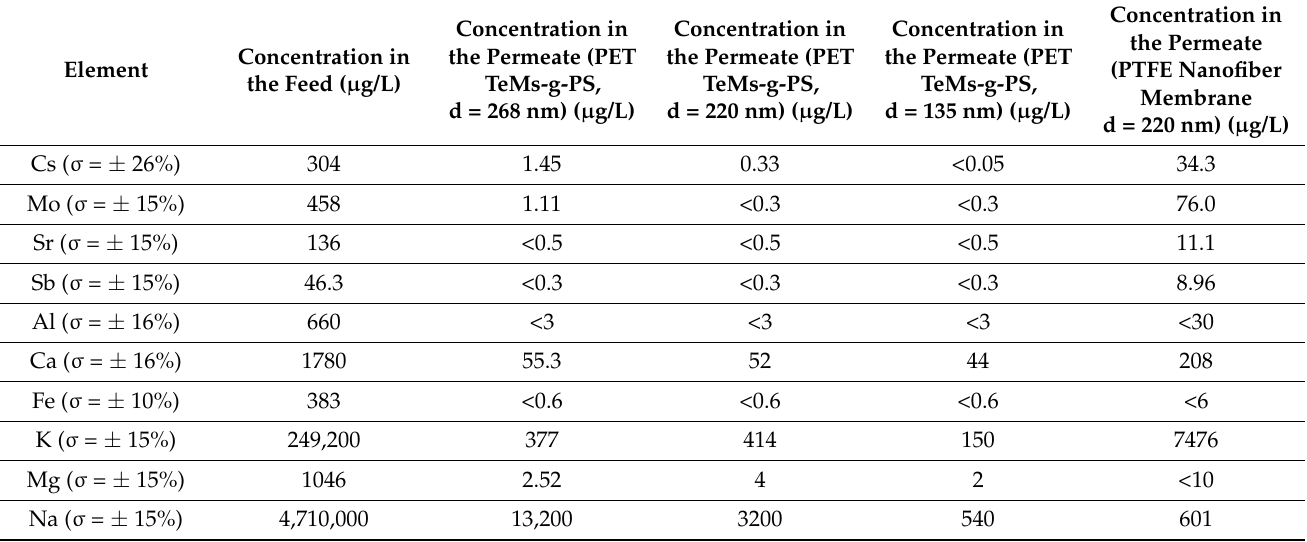
Table 3. Chemical composition of the LLLRW sample and the effluent after DCMD process.